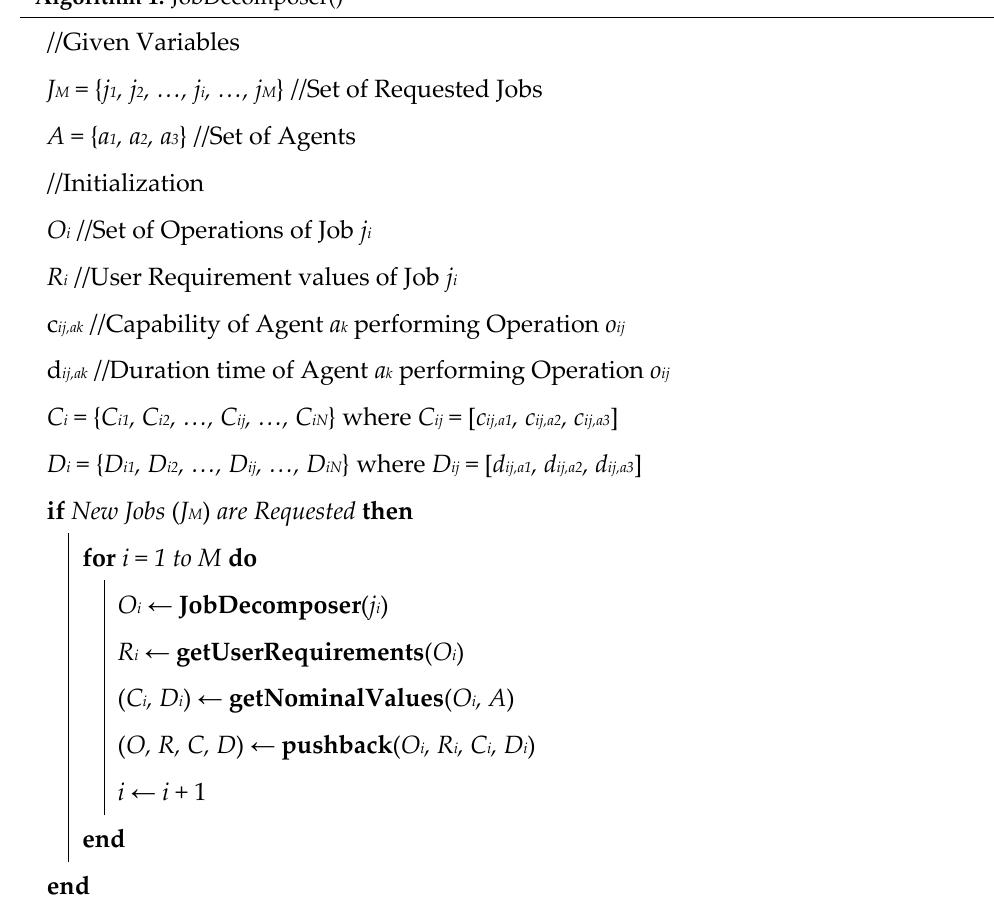
Algorithm 1: JobDecomposer()